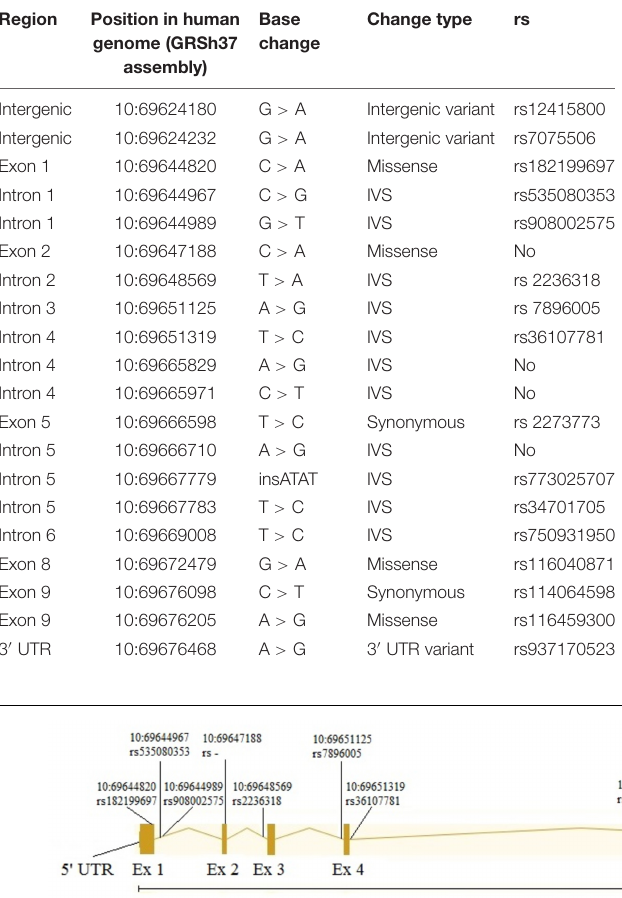
TABLE 1 | A list of the revealed SNPs in SIRT1 gene.